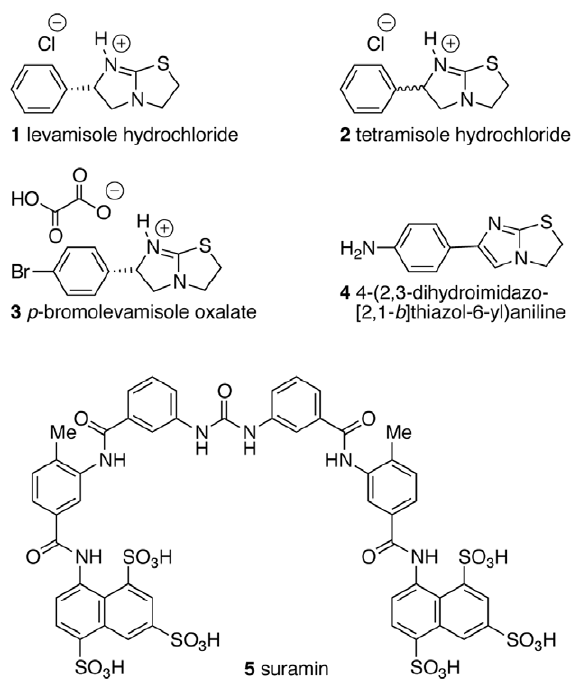
Figure 3. Commercially obtained compounds that were tested in this study.